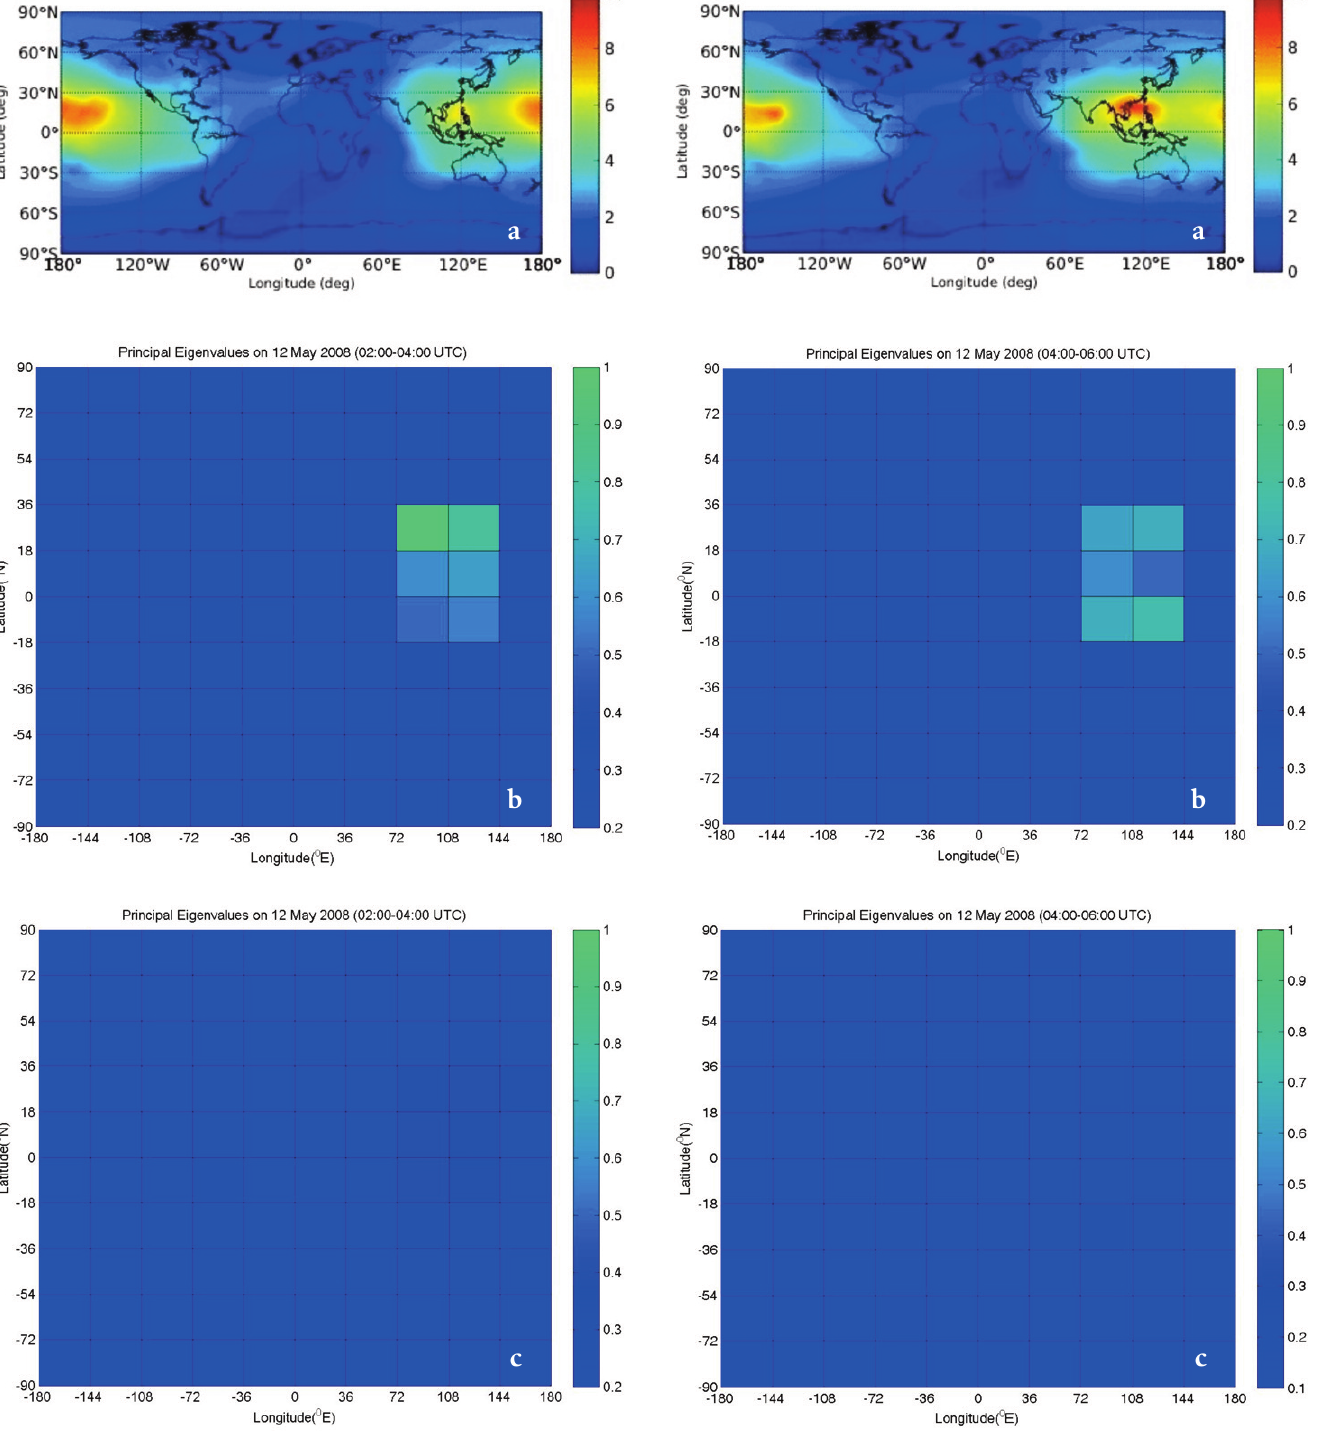
Figure 3. (a) The GIM on May 12, 2008, at heights of 150 km to 450 km for the time period 04:00-06:00 UT. (b, c) Color-coded scales of the magnitudes of principal eigenvalues using NLPCA (b) and PCA (c) corresponding to (a). See Figure 1, legend for further